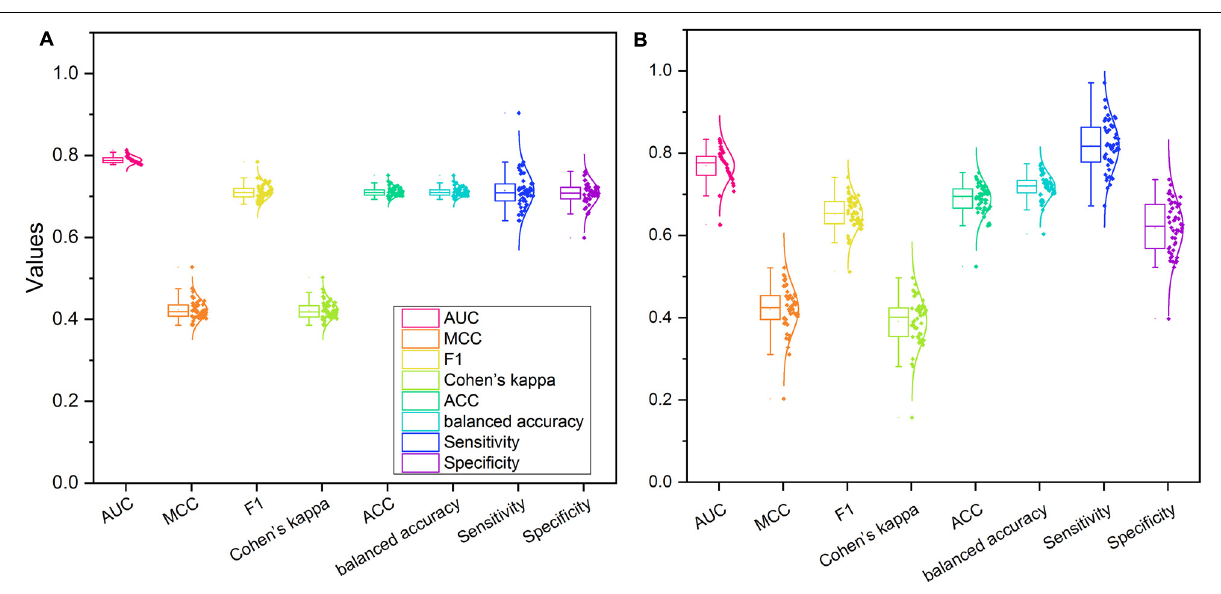
FIGURE 8 | The performance of the proposed DNN model based on the two different sampling strategies: (A) balanced data sampling; (B) drug-based data